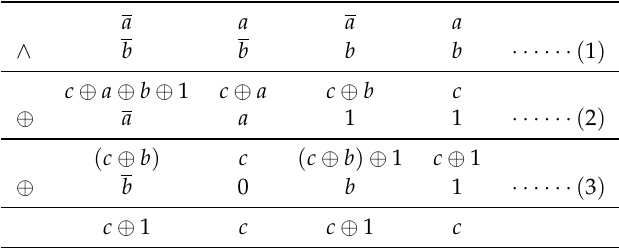
Table 3. Operation process of the constant AND.